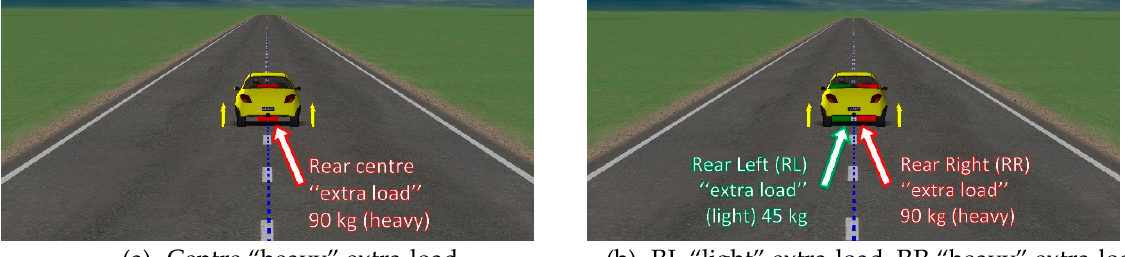
Figure 14. DLC Maneuver: 4IWM torques coordination: ( A ) 2WD (front) NO DIFF.{ d ( e ) }; ( B ) 2WD (rear) active DIFF.{ d ( b ) }; ( C ) 2WD (front) active DIFF. { d ( g ) }; ( D ) 4WD front prop.+rear DIFF. { d ( f ) }; ( E ) 4WD rear prop.+front DIFF. { d ( c ) }; ( F ) 4WD full prop.+full DIFF.{ d ( l ) }. [ 1 (B{ d ( b ) },C{ d ( g ) }) and 2 (D{ d ( f ) },E{ d ( c ) }) are dual layouts].